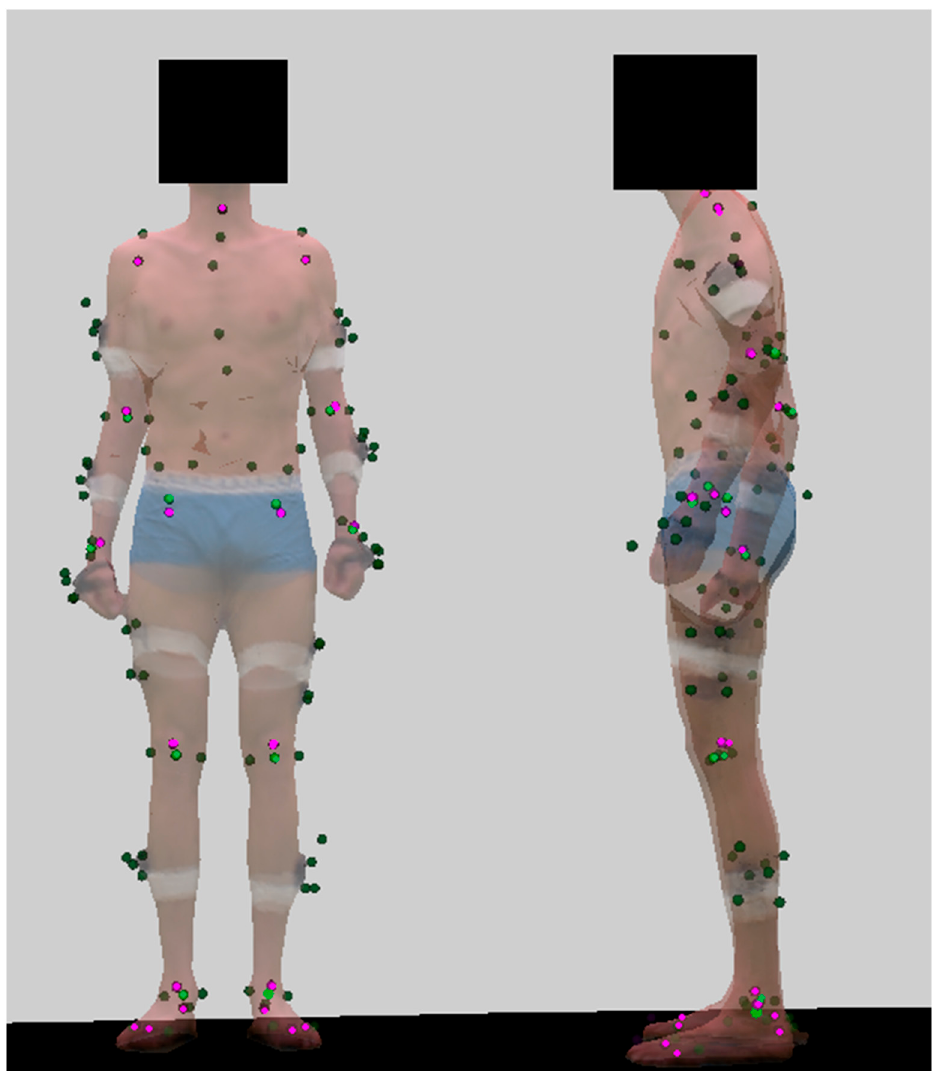
Figure 1. Triangulated anatomical markers and clusters (dark green), calculated joint centers (light green), and OpenPose BODY_25B keypoints (pink) on a textured mesh. OpenPose’s eyes and ears keypoints were excluded [25]. Mesh opacity was set to 0.5 in order to make all points visible. This view made it possible to precisely place OpenPose triangulated keypoints on the OpenSim